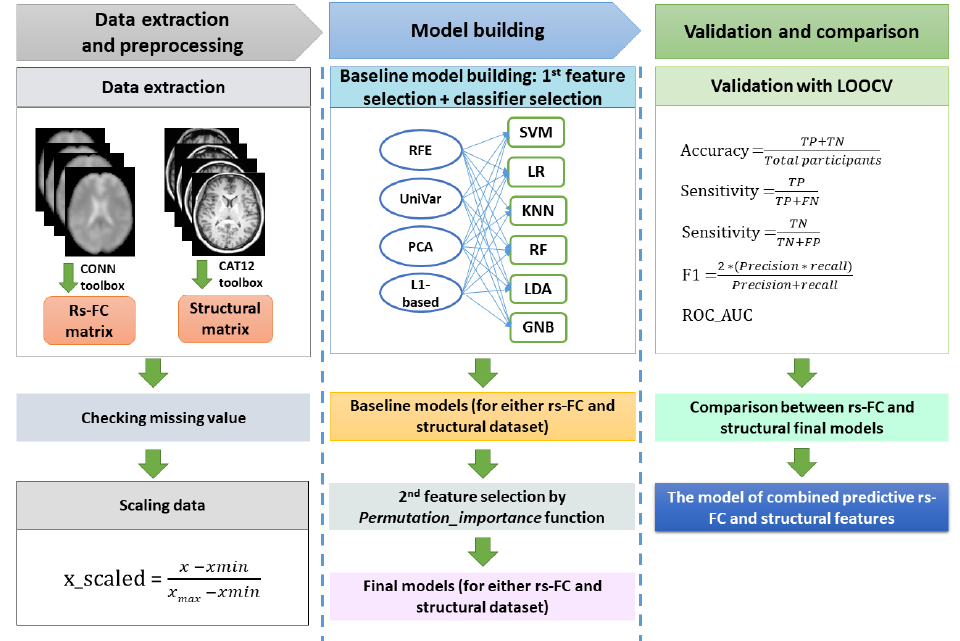
Figure 1. The machine learning procedure in this study. After extracting resting-state functional connectivity (rs-FC) data and structural data, both datasets were checked for missing values. Because rs-FC data were z-scores already, we just scaled structural data using the min-max scaling method. The baseline machine learning models for either the rs-FC dataset or structural dataset were built by selecting the best model among cross-combinations between four feature selection methods and six classifiers. Subsequently, feature importance function was applied on baseline models to remove features that had zero or negative features important scores, resulting in the final machine learning model for each of the rs-FC dataset and structural dataset. The performances of the two final models were compared to determine which was better for FM prediction. Finally, the predictive rs-FC and structural features were used to build the combined model to investigate the predictability of both functional and structural data. The validation for all models in this study were conducted with leave-one-out cross-validation (LOOCV). The performance matrix included accuracy, sensitivity, specificity, f1-score, and ROC_AUC. Note: TP = true positive; TN = true negative; FP = false positive; FN: false